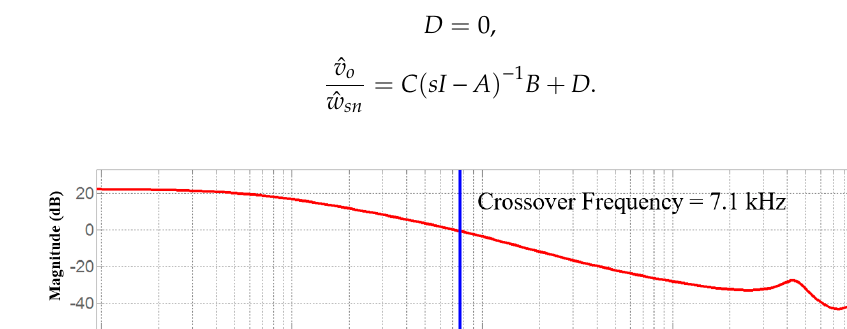
Figure 14. Bode plot of the small signal model of the LLC resonant converter.